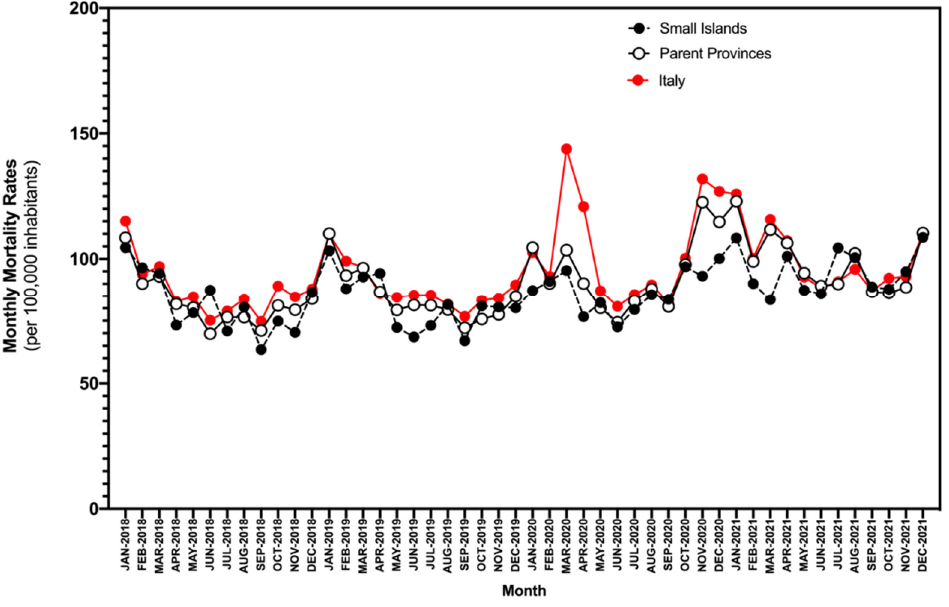
Figure 1. Monthly mortality rates (per 100,000) for Italian small islands, parent provinces, and national level (January 2018–December 2021).